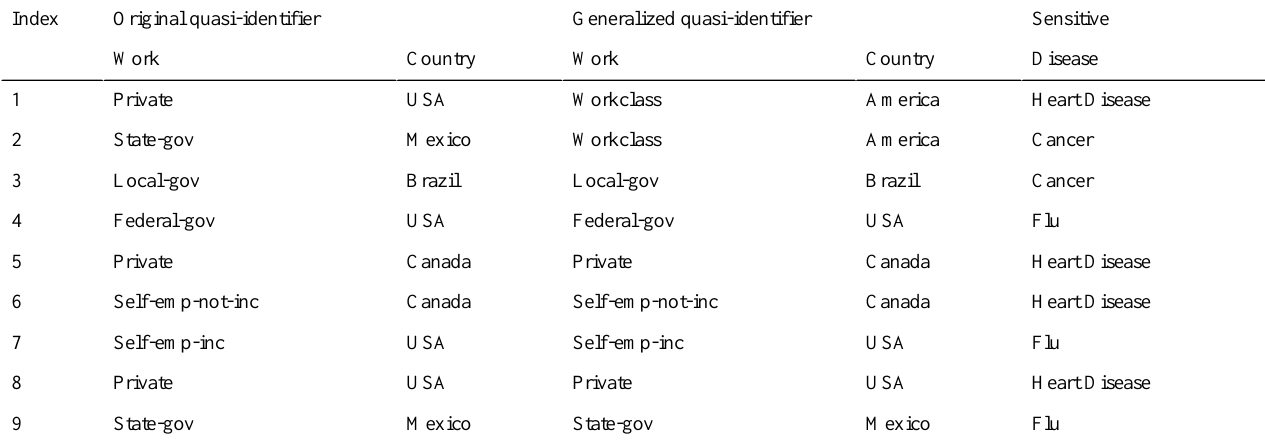
Table 4. Data table showing generalized QI attributes and sensitive attributes for first instance and second instance to explain conditional entropy and mutual